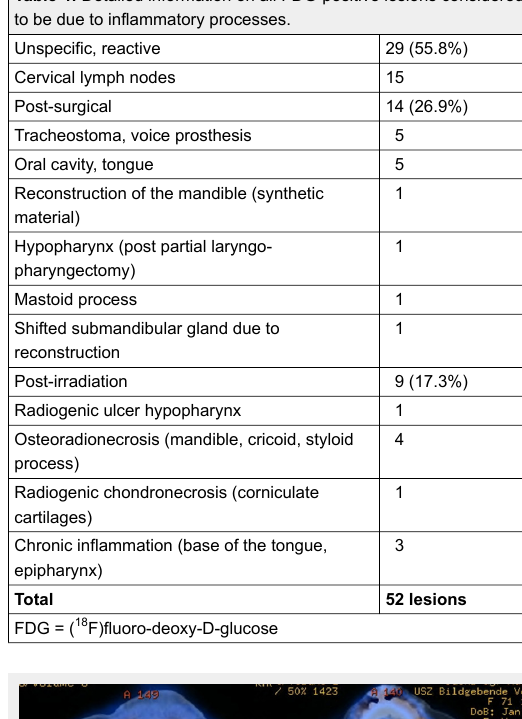
(A) Increased uptake in the right parotid gland in a 56-year old patient with a past medical history of radical parotidectomy and adjuvant radiation therapy (RT) on the left side due to a parotid gland carcinoma. Physiological uptake in the cervical brown fat tissue and the floor of mouth (FOM) muscles. (B) Increased uptake in the left paramedian FOM muscles due to muscular dysbalance in a 69-year old patient with a past medical history of surgical resection and RT of a right-sided base of the tongue carcinoma